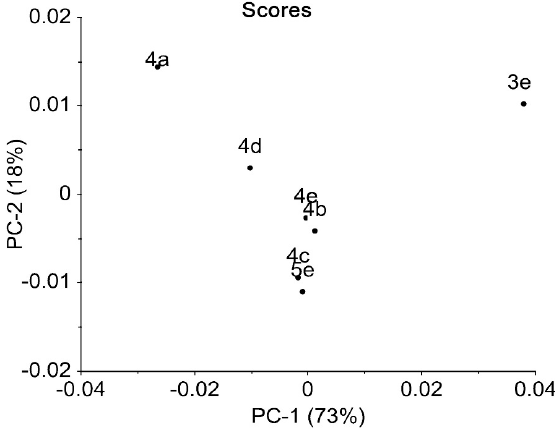
Figure 8. PCA results of IR spectra (reg. 3500–1750 cm − 1 ).